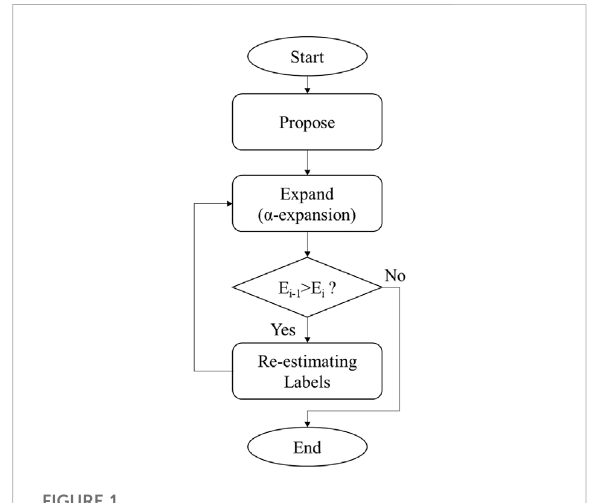
estimate Labels (PEARL)